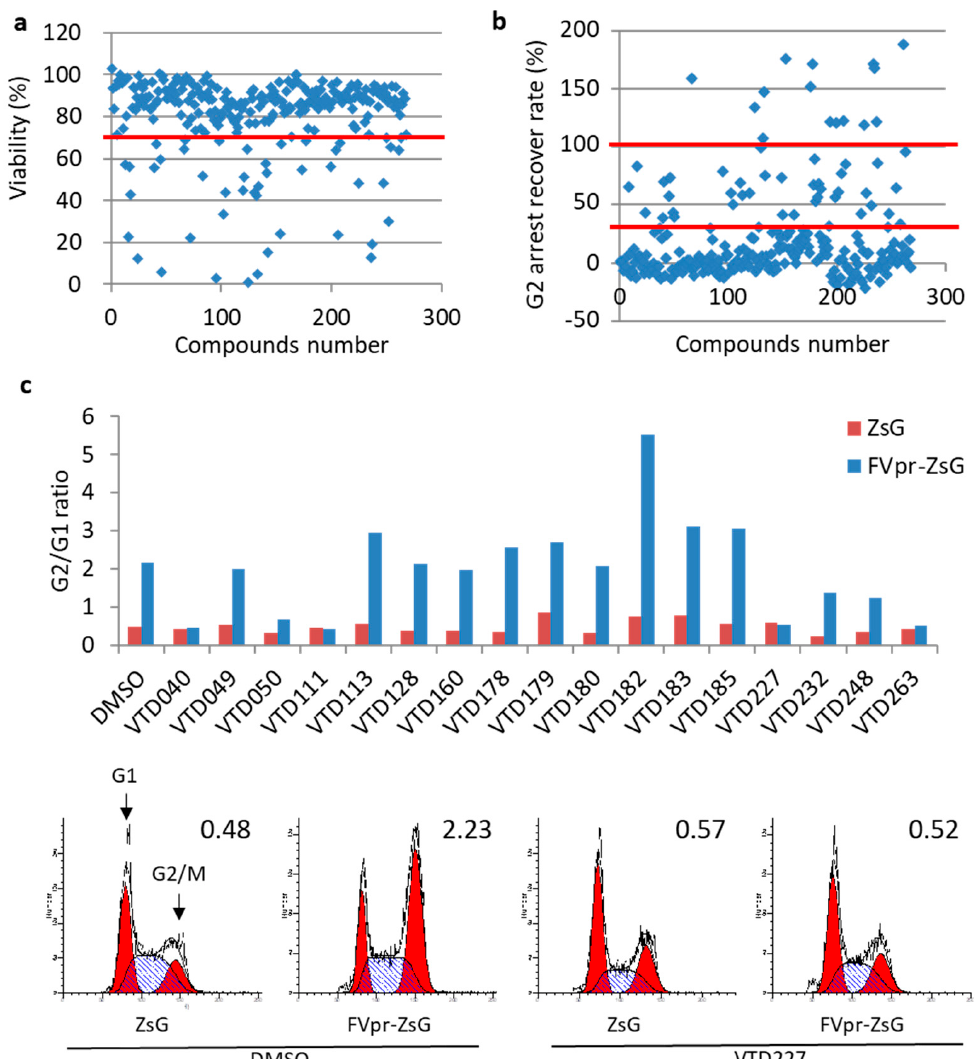
Figure 2. Secondary screening of Vpr inhibitor using HeLa cell-based high-throughput screening. ( a ) HeLa cells were treated with 10 µ M of 268 candidate compounds for 48 h, and the effect on the cell viability of each compound was assessed by WST-1 assay. The red line represents the threshold for high toxicity when the treated cells showed viability under 70% compared to the DMSO-treated control. ( b ) The HeLa cells were transfected with pME/Flag-Vpr-IRES-ZsGreenI and incubated at 37 ◦ C. At 4 h post-transfection, 224 candidate compounds were added at 10 µ M and incubated for an additional 44 h. The cells were fixed, stained with Hoechst 33342, and analyzed using CELAVIEW RS-100. The red lines represent the threshold for inhibition ranging from over 30% and not exceeding 100% of the G2/M arrest recovery rate. ( c ) The inhibition of the Vpr-induced G2/M cell cycle arrest was confirmed by the flow cytometry. The HeLa cells were transfected with either pME/Flag-Vpr-IRES-ZsGreenI (FVpr-ZsG) or the control pME/Flag-IRES-ZsGreenI (ZsG) and incubated at 37 ◦ C. At 4 h post-transfection, transfected HeLa cells were treated either with 10 µ M of 17 candidate compounds or vehicle (DMSO only). After 48 h, the cells were collected and stained with propidium iodide, and the DNA content of ZsGreenI-positive cells was measured by flow cytometry. The cell cycle was analyzed by Modfit software, and the G2/G1 ratio was calculated. Results of the G2/G1 ratio of 17 candidate compounds-treated cells (upper panel) and the typical model of the cell cycle analysis of a representative drug, VTD227 (bottom panel), are shown. Arrowheads indicate peaks of cells at the G1 and G2/M phases. The G2/M:G1 ratio is indicated in the upper right of each graph.